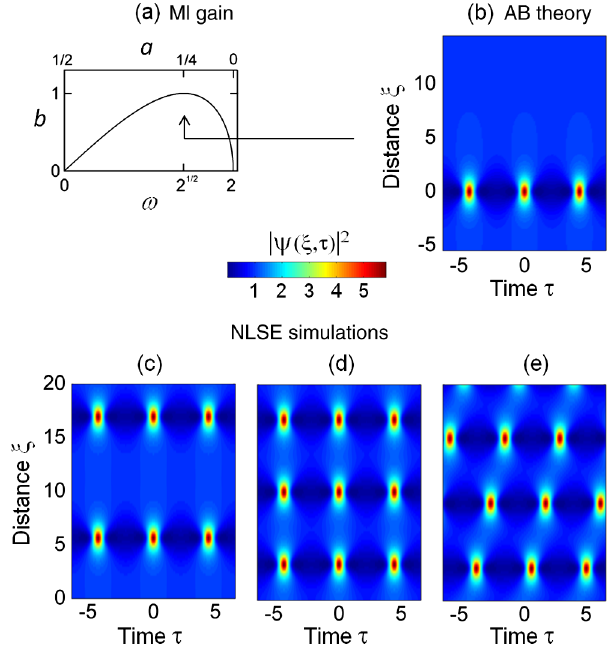
FIG. 1. (a) MI gain related to the general parameter a of AB theory. (b) False color plot showing the temporal evolution of the exact AB solution for a ¼ 1 = 4 . Note that only three temporal periods are shown. (c-e) NLSE numerical simulations showing the evolution of distinct (nonideal) initial perturbations on a continuous wave to excite a single AB. (c-d) Cosine perturba- tions with amplitudes equal to 0.01 and 0.1, respectively. (e) Exponential perturbation with amplitude equal to